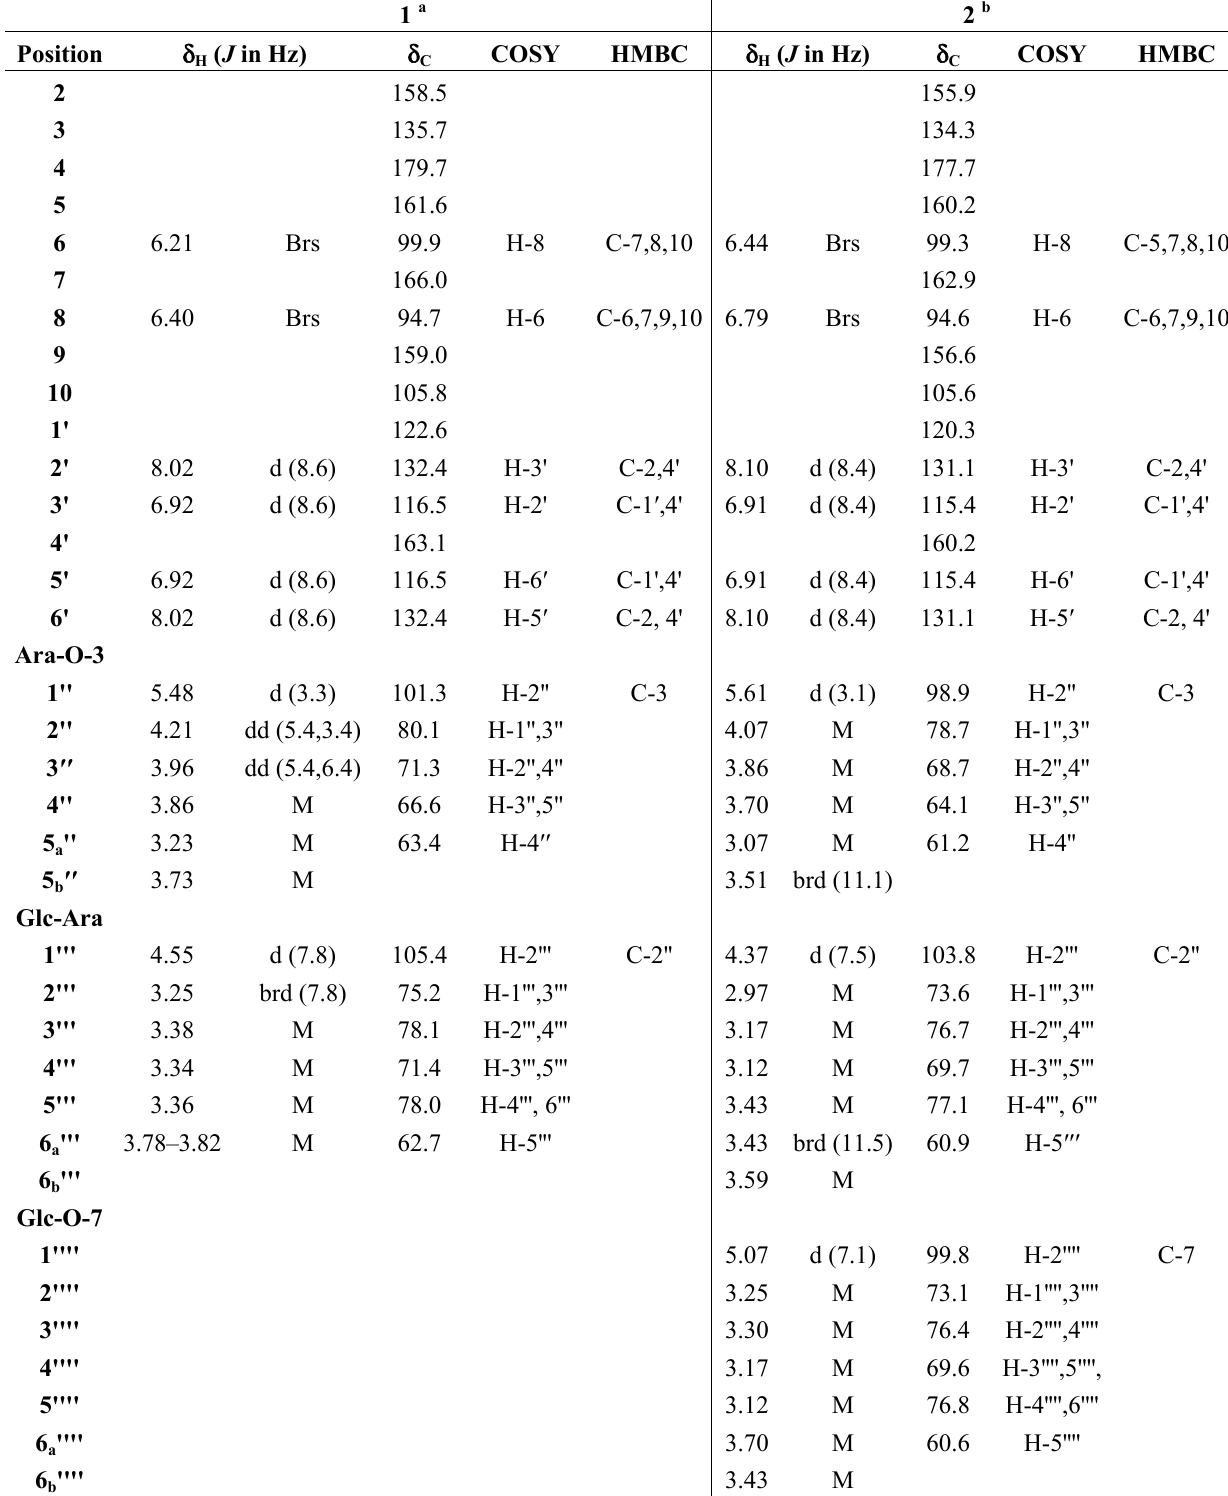
Table 1. 1 H-NMR, 13 C-NMR, and 2D-NMR spectral data for compounds 1 and 2